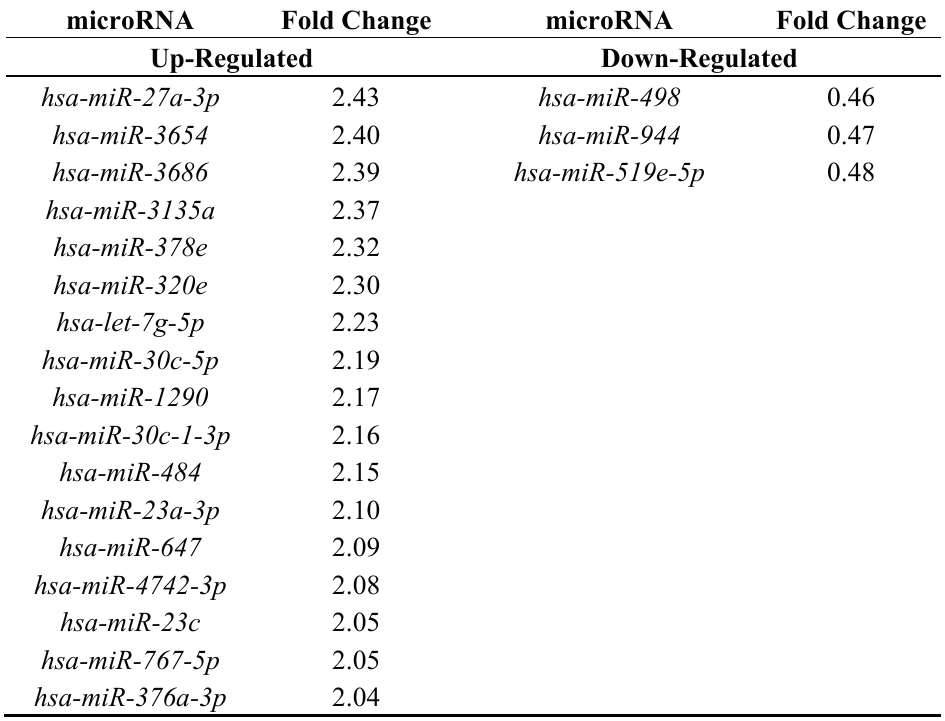
Figure 3. miRNA expression profiles were altered after PQ treatment for 24 h. Total